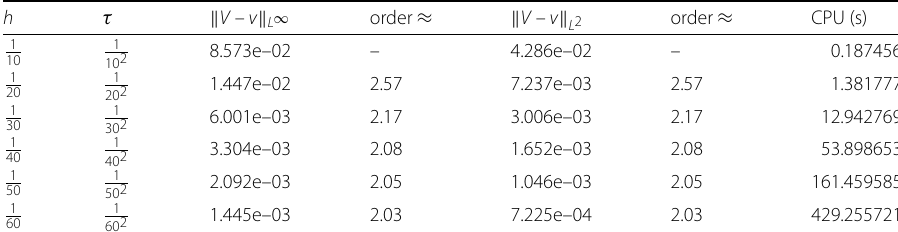
Table 4 Errors and computational orders of central difference scheme for